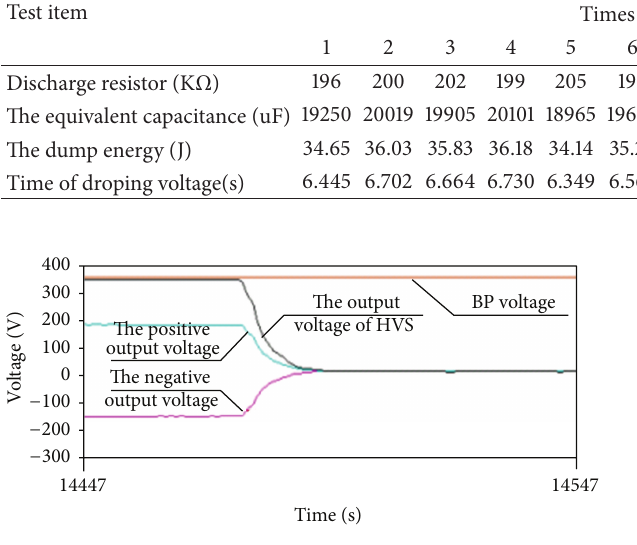
Figure 21: The test trial curve of high voltage